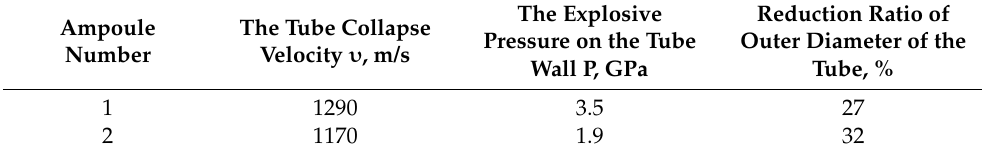
Table 2. The tube collapse